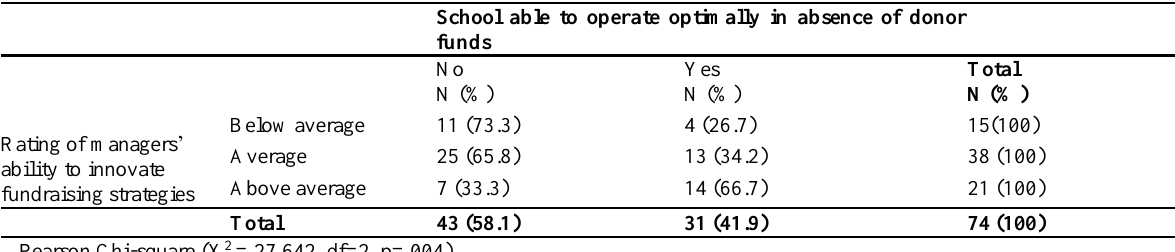
Table 6: Cross-Tabulation of Creativity and Sustainability beyond Donor Funding School able to operate optimally in absence of donor